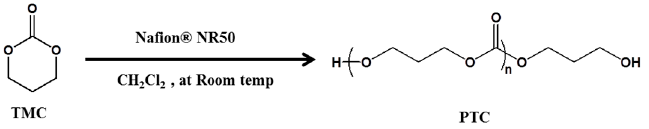
Figure 1. PTC synthesis.